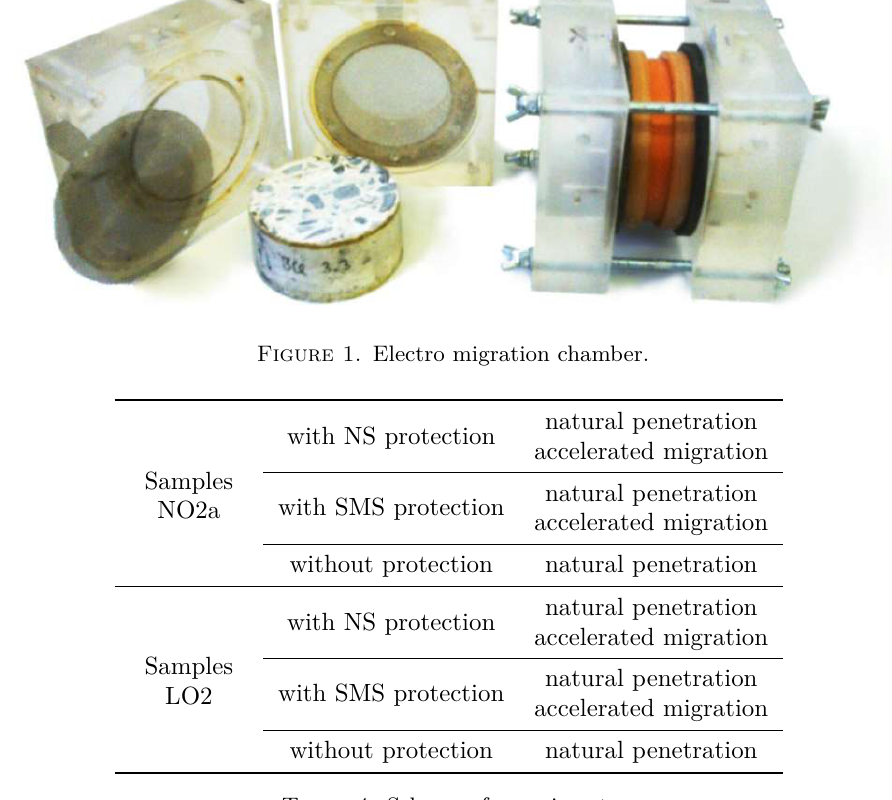
Table 4. Scheme of